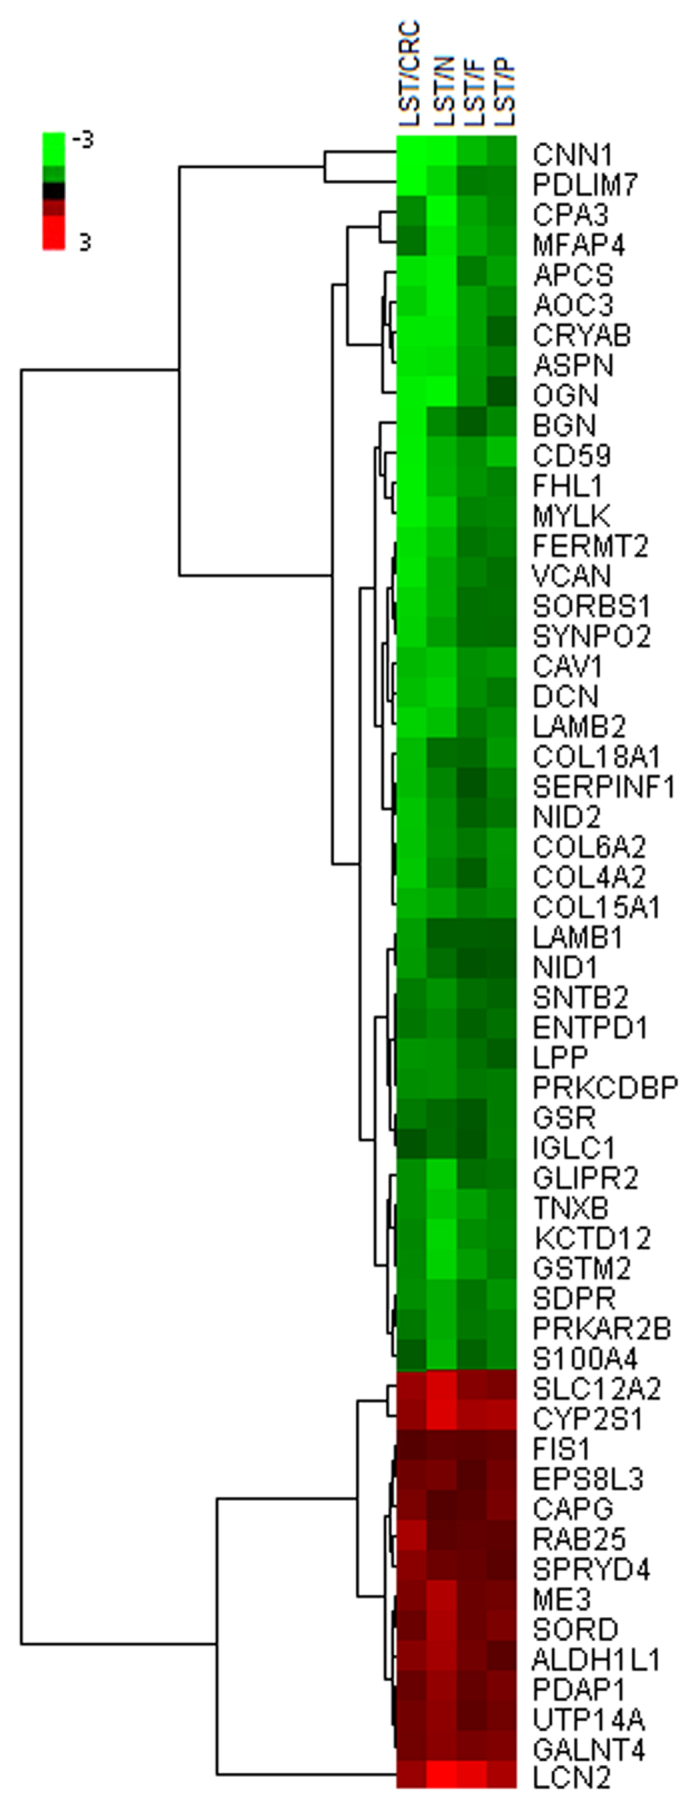
Cluster analysis of 55 differentially expressed proteins between LSTs and other groups.The protein expression levels are shown as colored boxes; red indicates a higher expression level and green indicates a lower expression level. LSTs: laterally spreading tumors, P: protruded-type adenomas, F: small flat adenomas, N: normal controls, CRC: TNM stage I colorectal carcinomas.